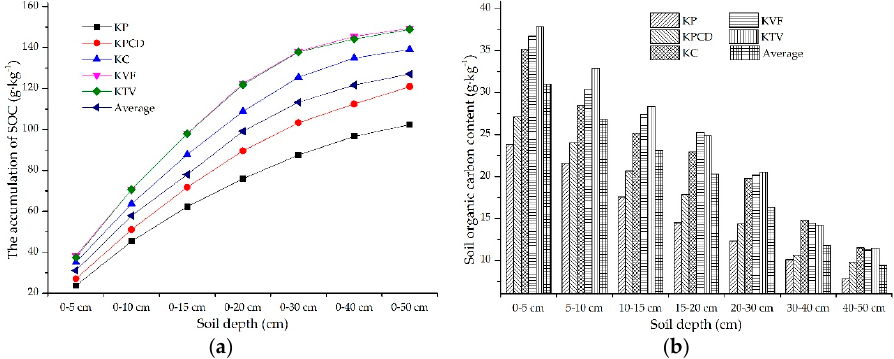
Figure 3. Spatial distribution of soil organic content (SOC) in different landform types with increasing soil depth: ( a ) shows the accumulation of SOC and ( b ) is the content of SOC in a single soil layer.